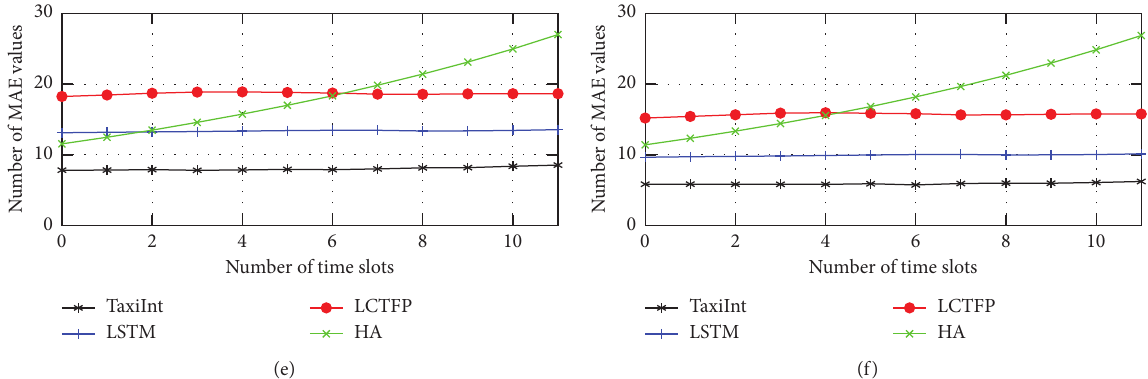
Figure 6: The prediction results of different methods. The above picture shows the prediction results of the four models for the six urban areas of Hangzhou. The vertical axis represents the prediction result error, and the horizontal axis represents the model’s prediction effect on the traffic flow at different time